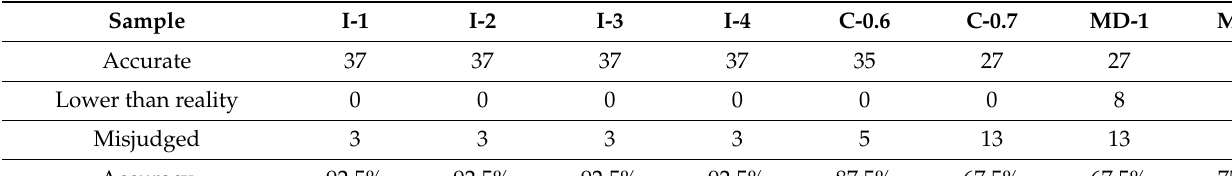
Table 6. Rockburst prediction results of each model.